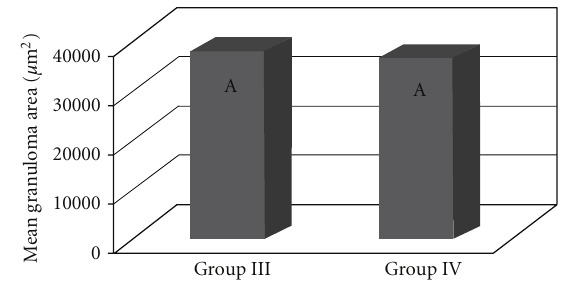
Figure 7: The total granulomatous area in the liver of the mice that were previously infected with the S. mansoni BH strain and then inoculated 8 weeks later with eggs from the S. mansoni BH (Group III) or SJ (Group IV) strains. The means with same letter do not di ff er significantly ( α = 0 . 05).